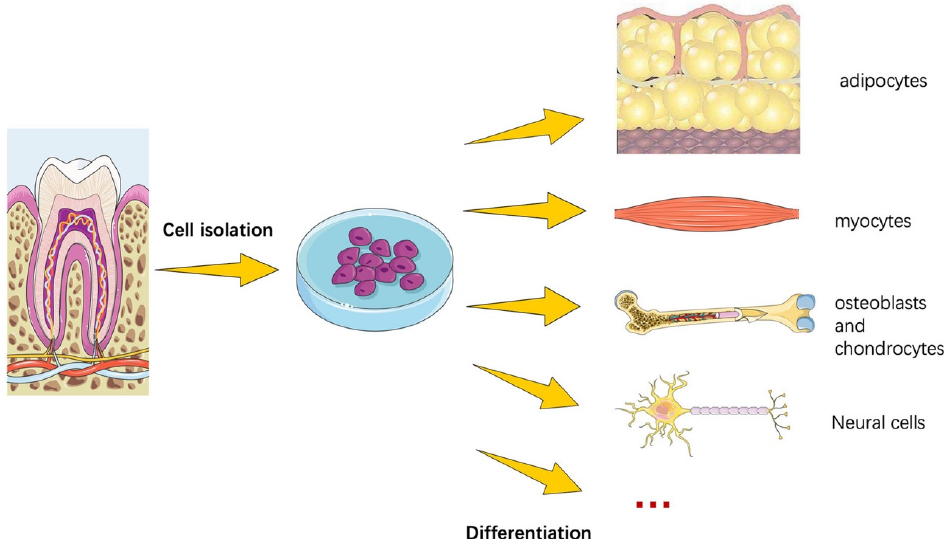
Figure 4. DSCs, similar to members of the MSCs family, have the capacity to differentiate into several lineages. Experiments have shown that given the right conditions, DSCs may develop into bony tissues such as osteoblasts, adipose tissues such as adipocytes and chondrocytes, and nerve and neuronal tissues. The figure was adapted from Wang et al. (2019) [181] .